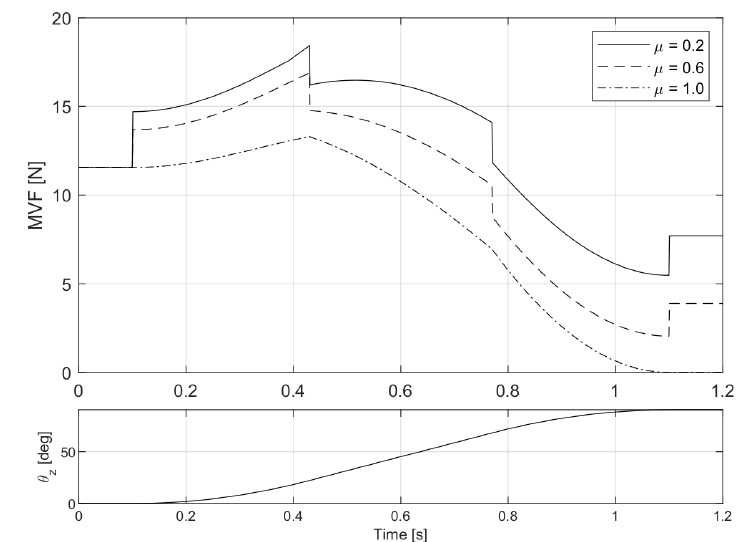
Figure 8. In the upper plot , minimum vacuum force required during the rotation of a trapezoid object as a function of time; results are presented for different friction coefficients. In the bottom plot rotation angle θ z , the two plots shares the x-axis.